Question: Write a caption explaining this figure to a reader.
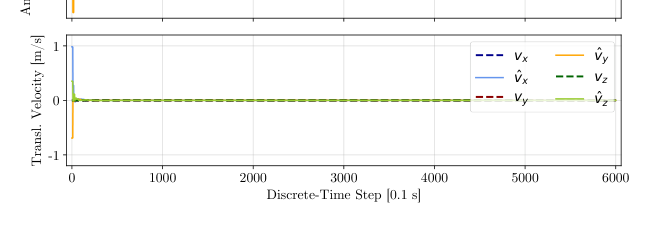
Answer: EKF results using the trained parameters for DS1 applied on DS1. Each of the four subplots depicts one of the four motion components from the state vector: orientation, position, angular velocity and translational velocity. In every subplot, the EKF estimate and the corresponding measurement or ground truth are plotted, denoted as ˆx, ˜x and x, respectively.